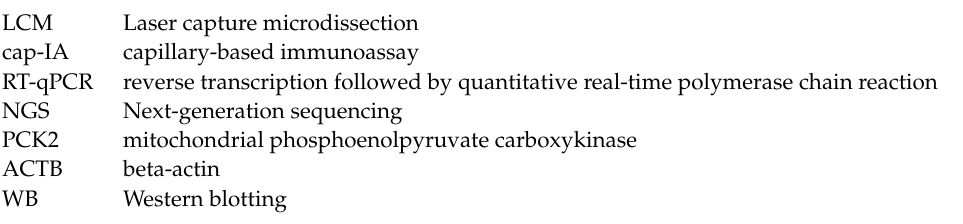
thickness; Figure S2: Calibration curve for protein estimation of LCM sample Table S1: Estimation of protein amount in LCM sections, Table S2: Normalized values of PCK2 in β -cells of diabetic and control groups for each